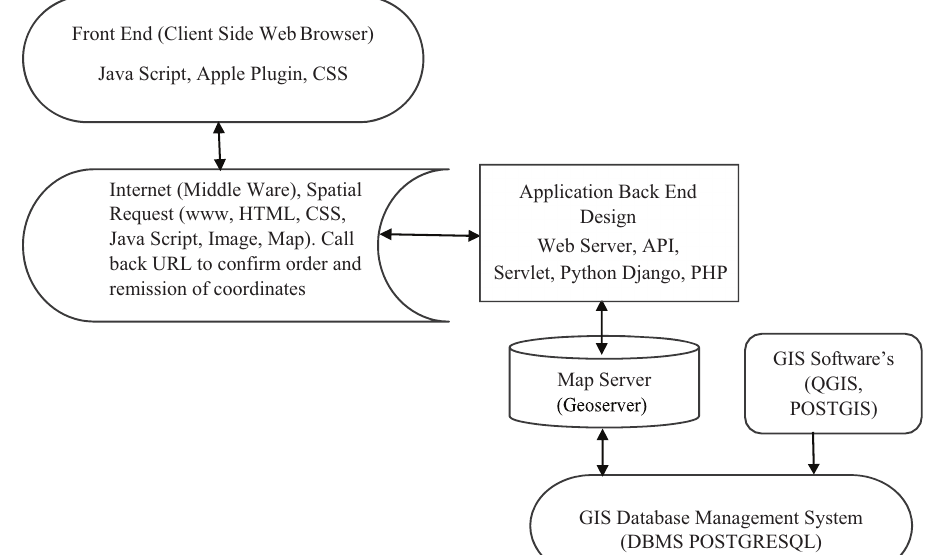
Figure 3. System implementation